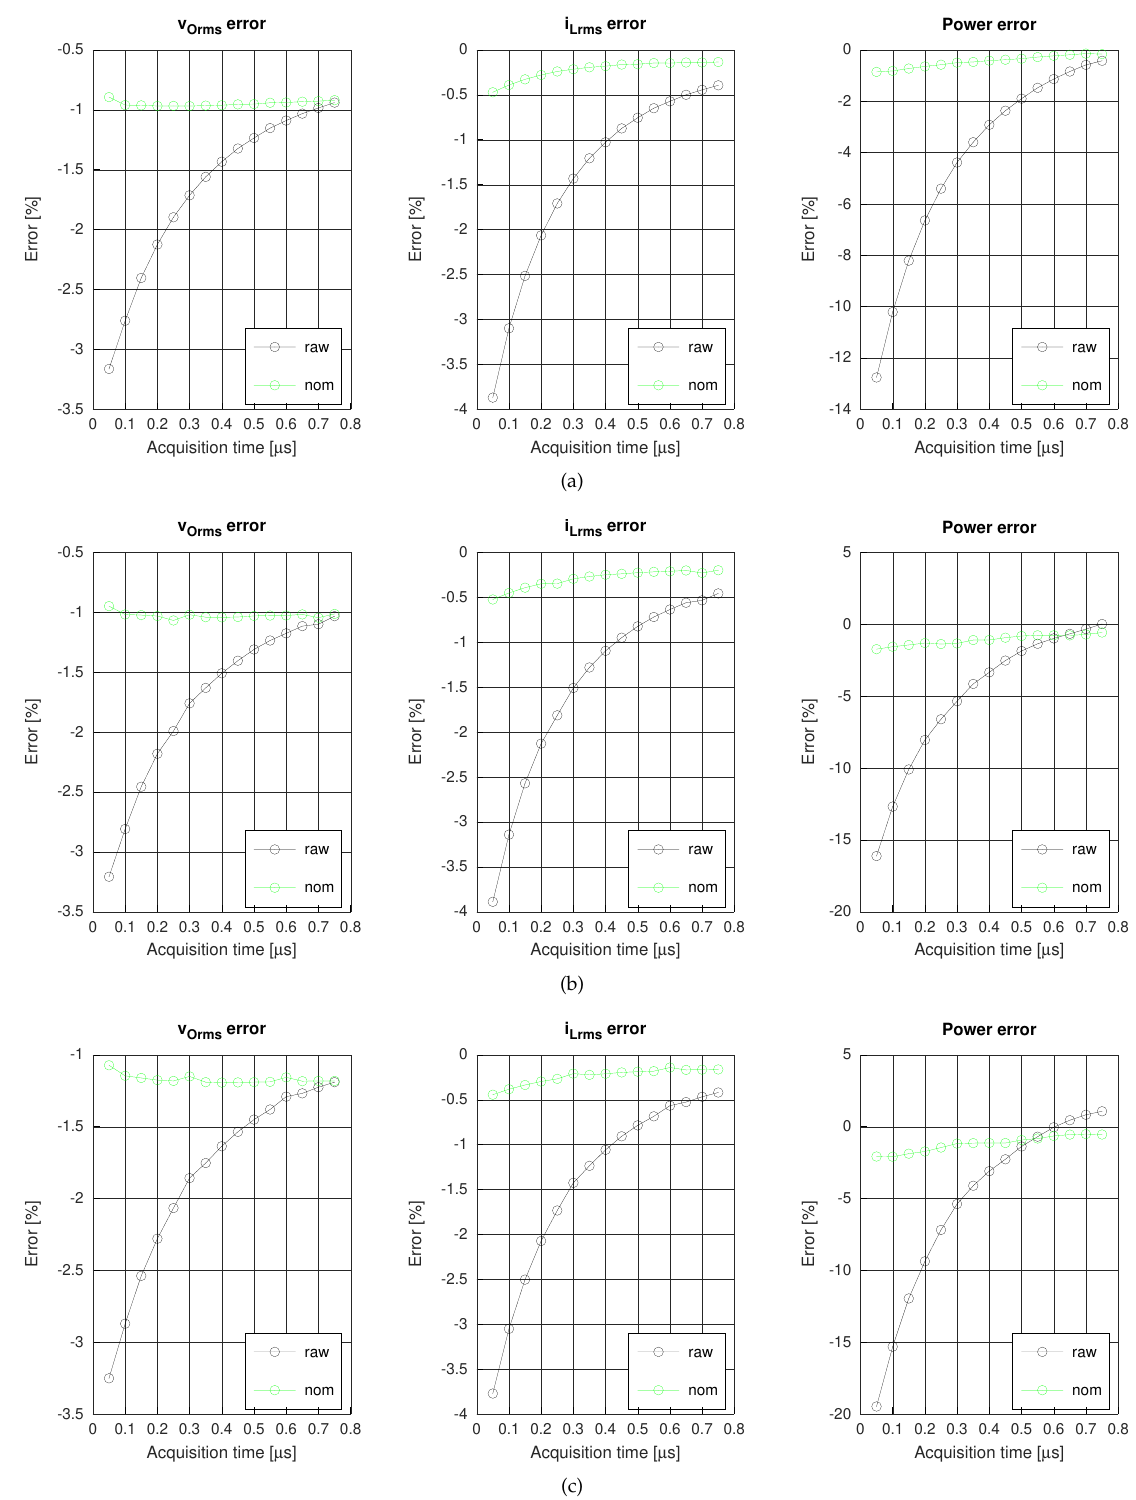
Figure 11. Voltage, current and power errors with raw data and correction method with nominal values for switching frequencies of ( a ) 35 kHz, ( b ) 50 kHz, and ( c ) 70 kHz. The accuracy can be further raised by using the parameters found by the minimization